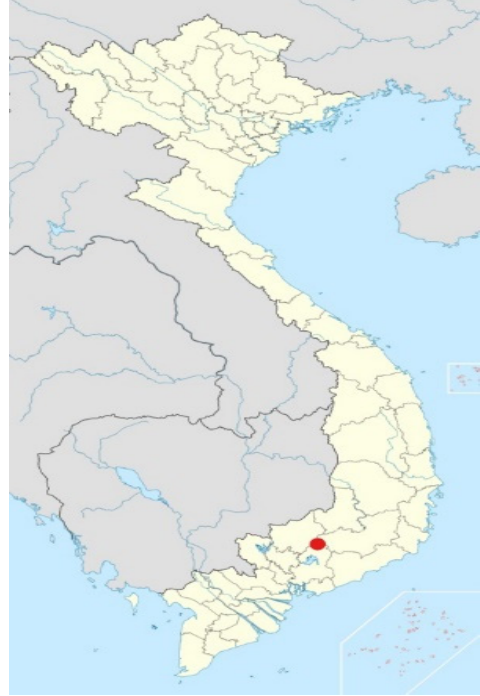
Figure 1. Location of Cat Tien National Park. Source: compiled by the research team.